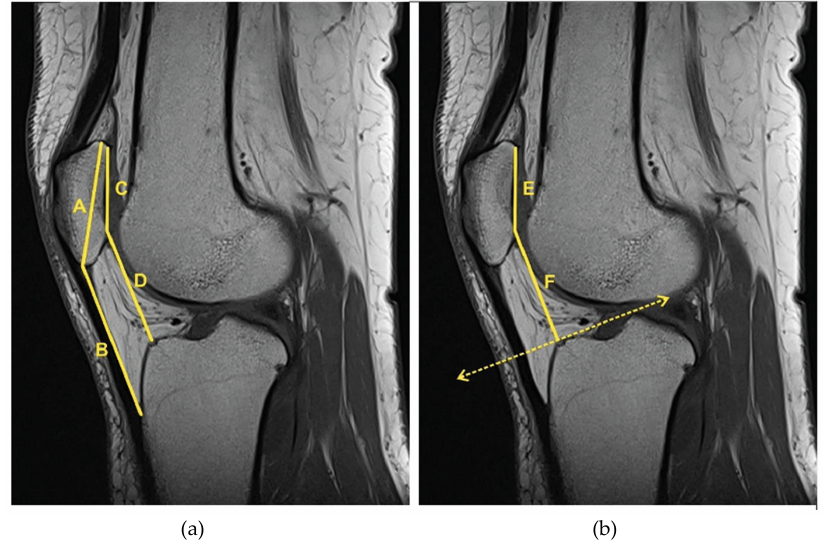
Figure 2. ( a ) Insall–Salvati index (IS) (B/A): patellar tendon length from the lower pole of the patella to the tibial tuberosity (B) to the diagonal length of the patella (A). Caton–Deschamps Index (CD) (D/C): distance from the inferior edge of the articular surface of the patella to the anterior edge of the tibial plateau (D) to the articular surface of the patella (C). ( b ) Blackburne–Peel index (BP) (F/E): distance between the tibial plateau line and the inferior point of the patellar articular surface (F) to the length of the patellar articular surface